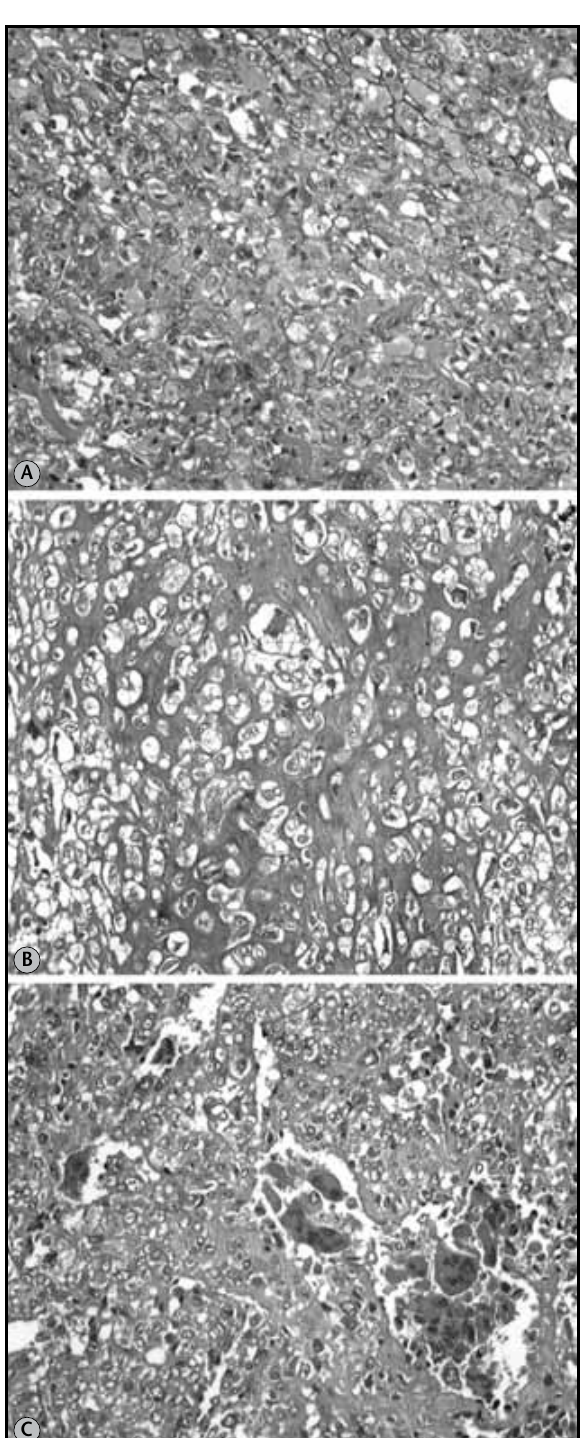
Figure 4 – Photomicrographs of HE stained sections showing microscopic featu- res of the carcinosarcoma. (A) undifferentiated sarcoma; (B) chondrosarcoma; (C) osteoclastoma/malignant giant cell tumor areas HE: hematoxicilin and eosin. All photomicrographs taken at 200×